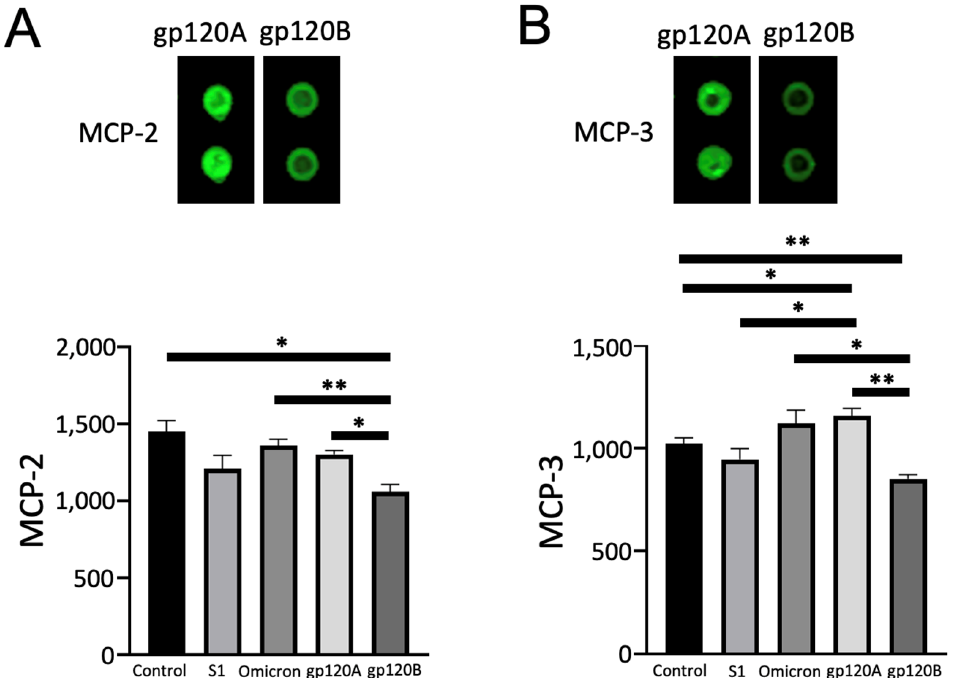
Figure 6. gp120 proteins of HIV-1 Group M Subtype A and Subtype B differentially affect MCP-2, and MCP-3 expression. Human pulmonary artery endothelial cells were treated with SARS-CoV-2 spike proteins S1, Omicron S1, and gp120 of HIV-1 Subtype A (gp120A) or Subtype B (gp120B) at 1 nM for 20 h in triplicate. Expression patterns of various proteins were monitored using R&D Human XL Oncology Array. ( A ) MCP-2 was found to be higher in gp120A-treated cells. ( B ) MMP-3 was found to be higher in gp120A-treated cells. Representative images are shown at the top. Densitometry values from two spots from each array were averaged, and statistical analysis was performed using results from three separate treatments/arrays. Bar graphs represent means ± SEM (N = 3 for all groups). * p < 0.05. ** p < 0.01. The y-axis indicates the mean pixel density of protein spots.